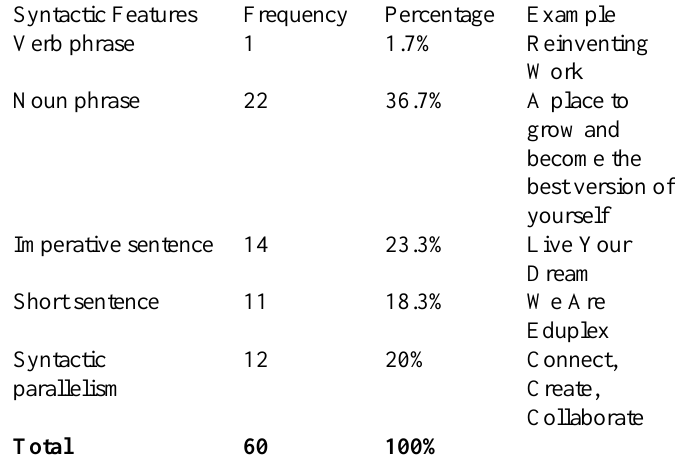
TABLE 3 | Syntactic Features in Coworking Spaces